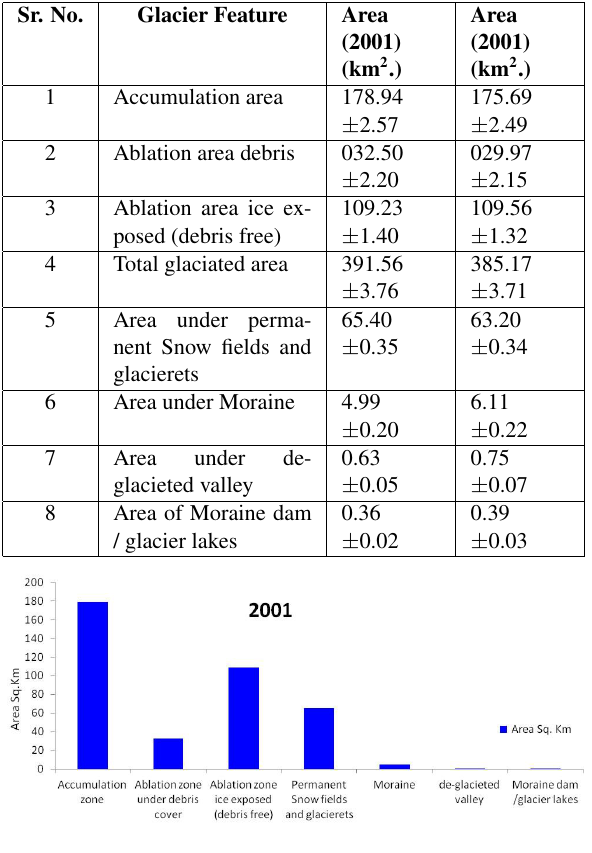
Figure 6: Statistical distributions of glacier features (2001)